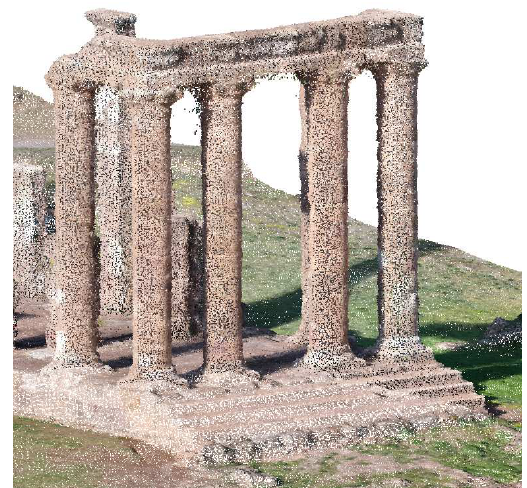
Figure 12. 3D point cloud model of the colonnade